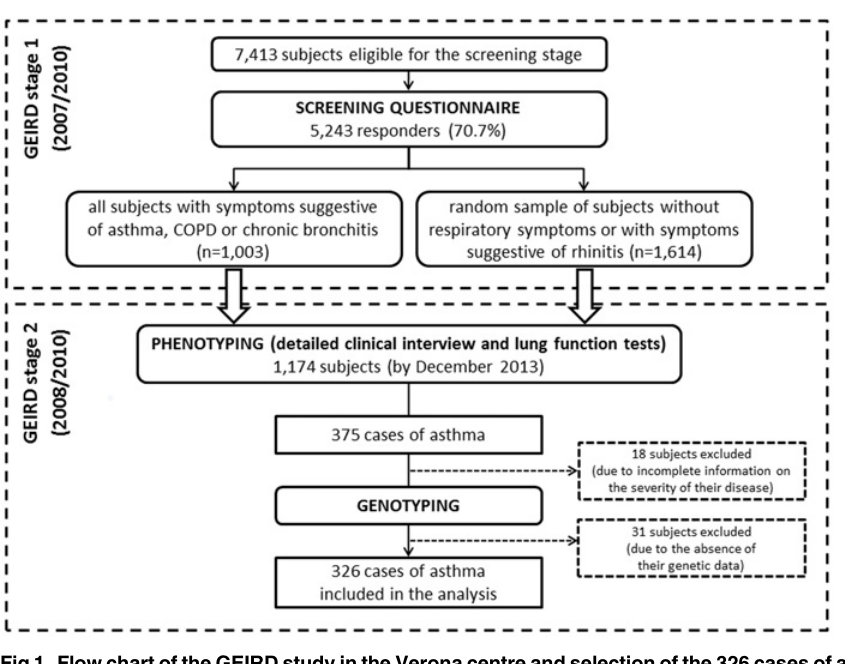
Fig 1. Flow chart of the GEIRD study in the Verona centre and selection of the 326 cases of asthma included in the analysis.